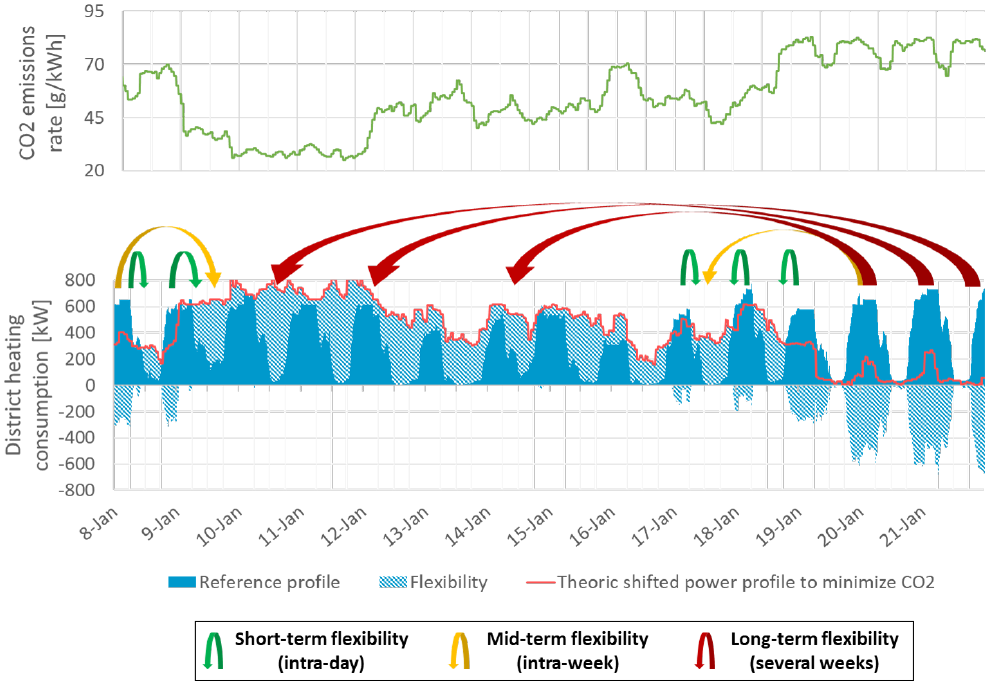
Figure 13. Theoretical maximal flexibility to minimize CO 2 emissions by shifting 10-min values from the reference profile.